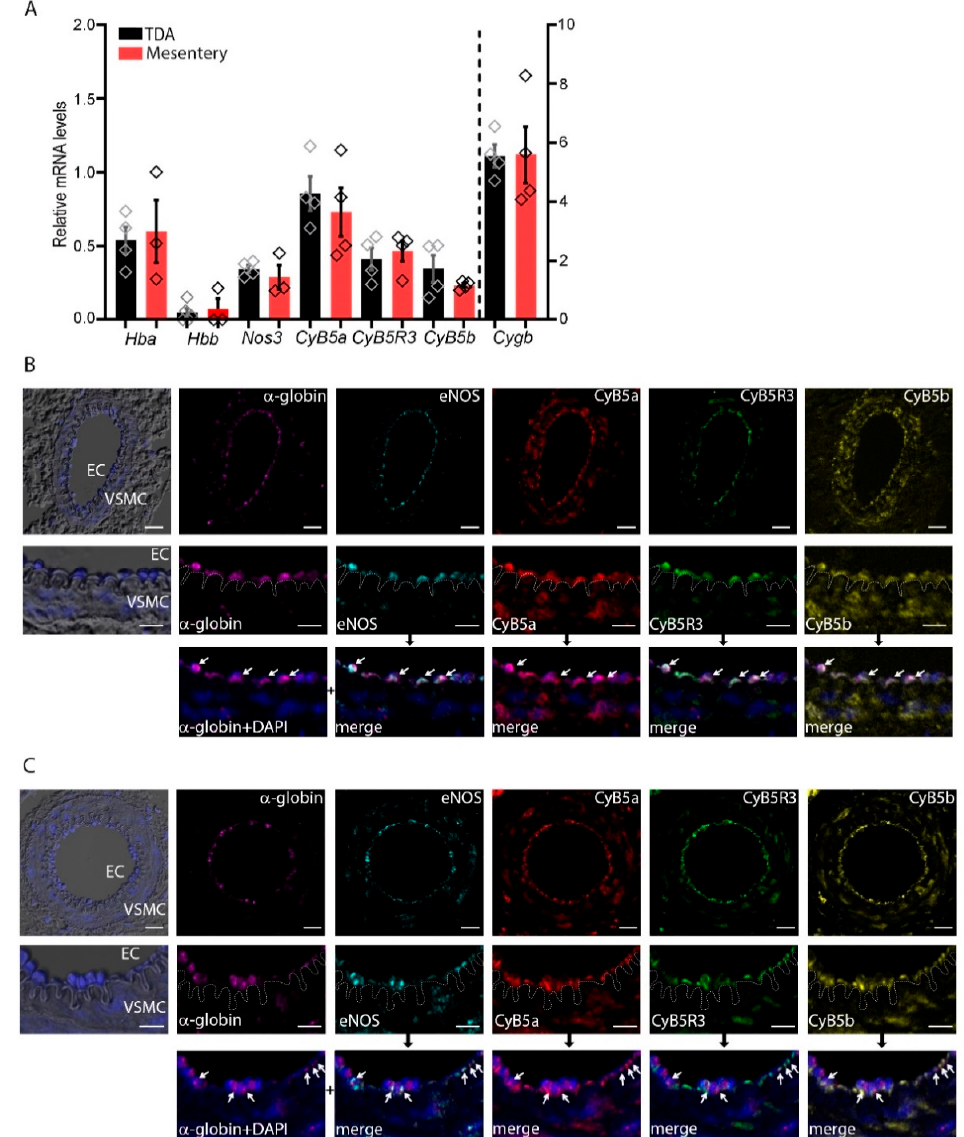
Figure 1. α -Globin and redox systems are co-expressed in small arteries. ( A ) mRNA levels in the thoracodorsal artery (TDA) and mesenteric arteries. The bar chart shows data from three or four 6-month-old mice. ( B , C ) Indirect immunofluorescence multiplexing staining for α -globin, endothelial nitric oxide synthase (eNOS), CyB5a, CyB5b, and CyB5R3 (white arrows) in TDA ( B ) and mesenteric artery ( C ) preparations. The dashed line across the internal elastic lamina demarcates the ECs and VSMCs. Merges represent the overlap of “ α -globin+DAPI” with other staining based on the black arrow upstream. DAPI-stained nuclei are shown in blue, in combination with differential interference contrast. Scale bars are equivalent to 10 μ m and 20 μ m (for the higher magnification).